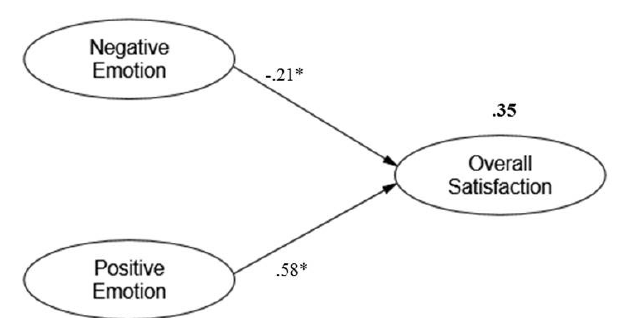
Figure 1. Estimated standardized direct effects for the structural model. Note: * p <